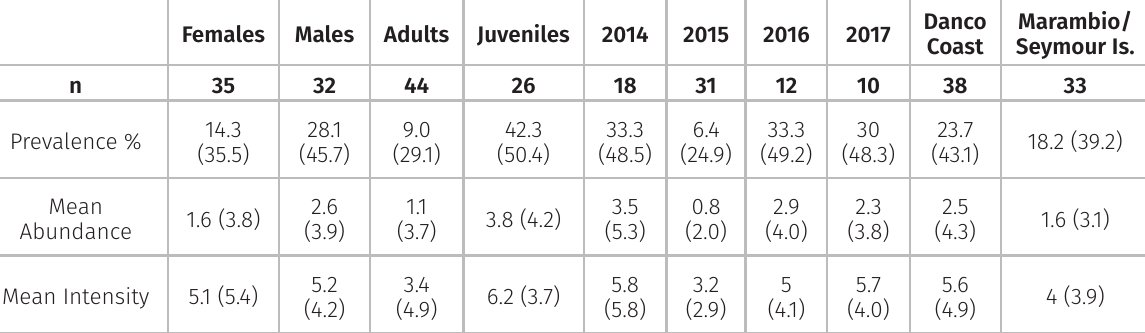
Table I. Total number of hosts analyzed (n), infestation parameters and standard deviation (in parenthesis) for Antarctophthirus carlinii from Weddell seals by host sex and age class, year, and site. Females